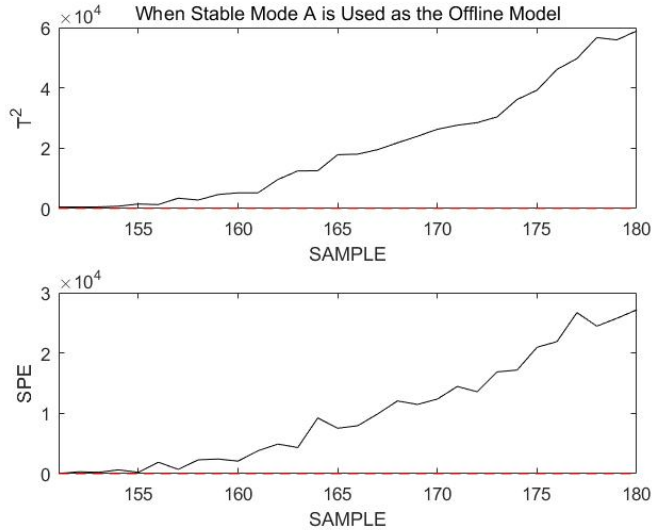
Figure 17. Monitoring 151st to 180th sample points using stable mode A as an offline model.